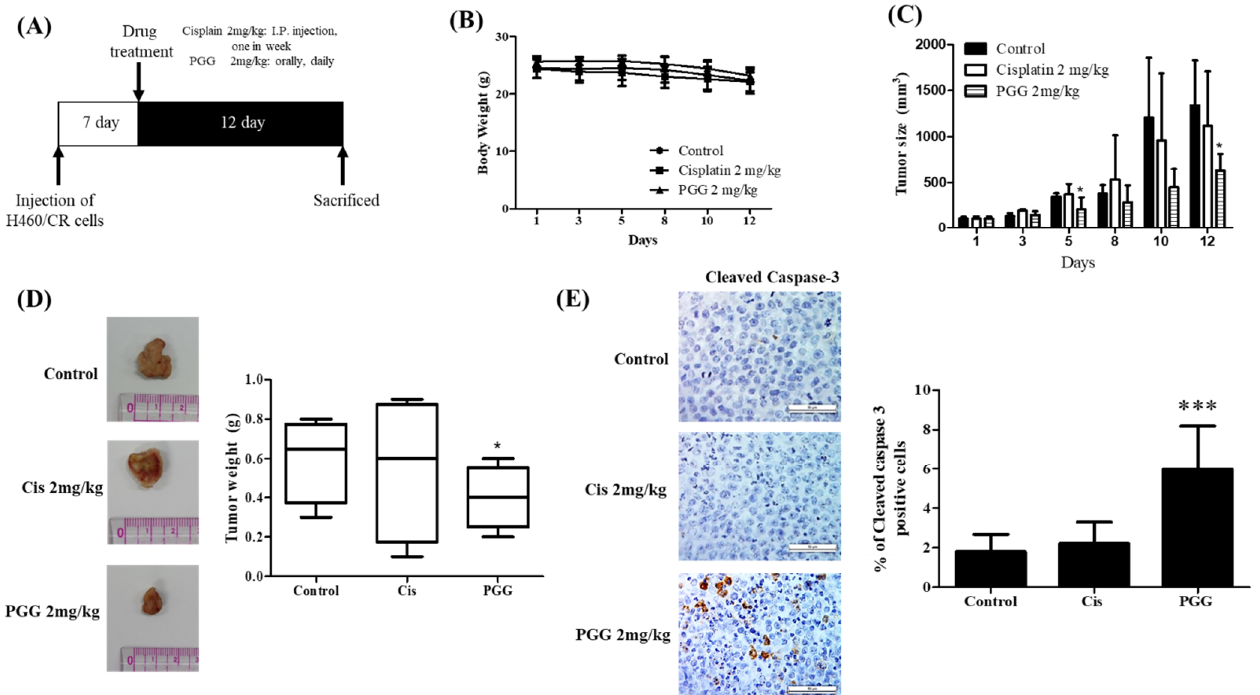
Figure 7. PGG suppresses the growth of H460/CR cells in BALB/c nude mice with increased caspase 3. ( A ) Time schedule of animal study with PGG or cisplatin at a dose of 2mg/kg. ( B ) Effect of PGG treatment on body weight. ( C ) Effect of PGG treatment on tumor volume in mice implanted with H460/CR cells. ( D ) Tumor morphology and tumor weight of mice treated by PGG or cisplatin. *, p < 0.05 vs. cisplatin control ( E ) Effect of PGG or cisplatin on cleaved caspase 3 in tumor sections isolated from mice. Immunostaining of cleave caspase-3 (scale bar = 50 μm). Cleaved caspase-3-positive cells were counted in 10 random areas at 400x magnification and analyzed using image J. Quantification represents the percentage of cleaved caspase 3 positive cells. Data represent means ± SD. *** p < 0.001 vs. untreated control.